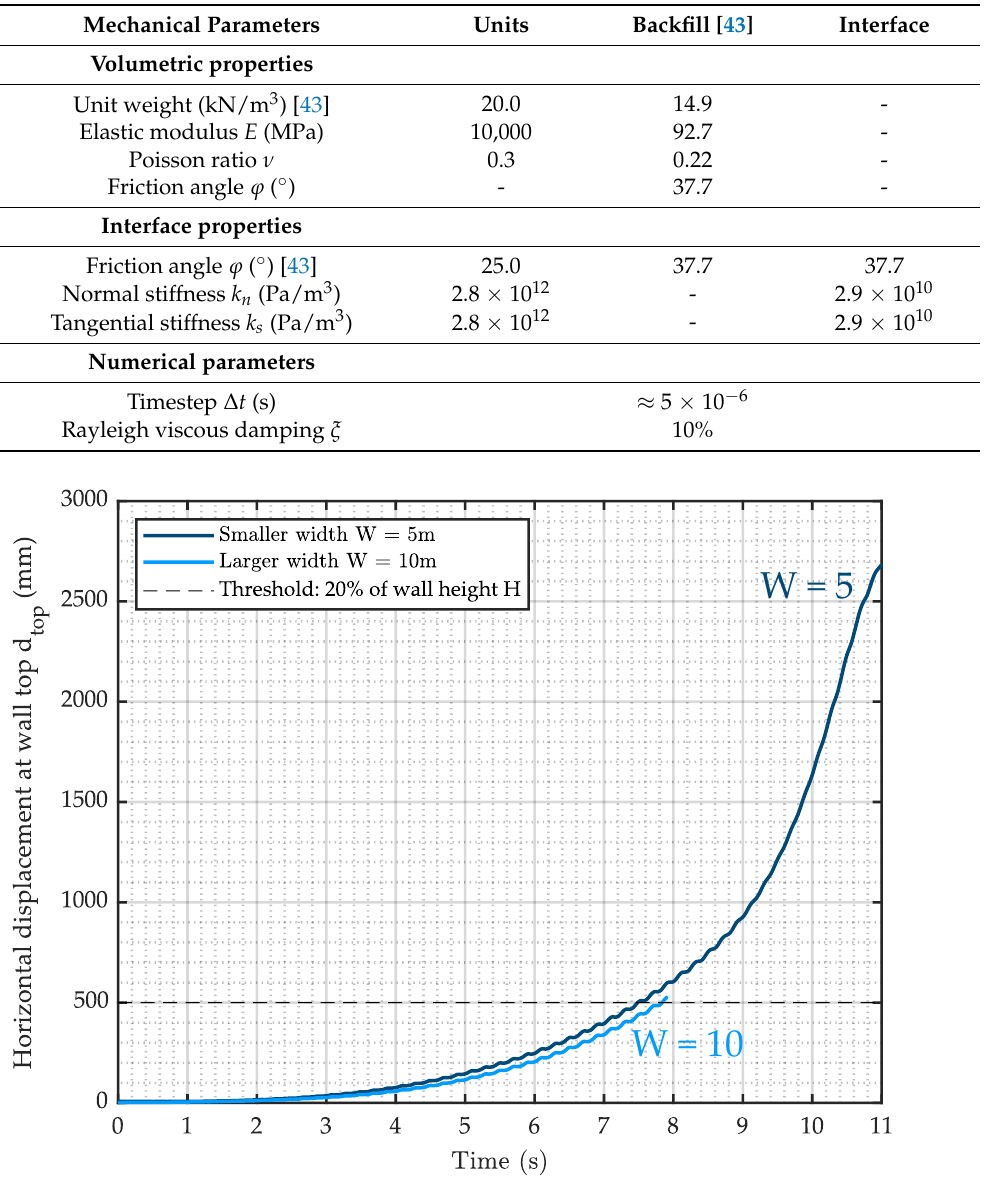
Table 6. Mechanical parameters of the full-scale DSRW simulations. Most of the data come from the reference experimental study [16,24,43], while the rest is taken on a default basis.